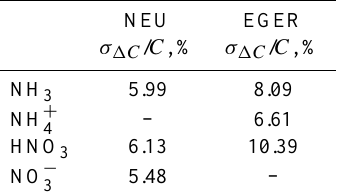
Fig. 9. Residuals of 1C for side-by-side measurements after correcting the data for systematic deviations using the orthogonal fit for (a) HNO 3 (EGER) and (b) NH 3 (NEU). The lines indicate fitted Laplace (blue) and Gaussian (red) distributions. Table 5. : Percentage of significant 1C (values larger than σ 1C ) Table 4. Errors of the concentration difference, relative to the am- during gradient measurements for NEU and bient concentration, σ 1C / C , determined for NEU and EGER. For particulate NH + during NEU and particulate NO − during EGER 4 3 only absolute values independent of C could be determined (see text and Table 3).